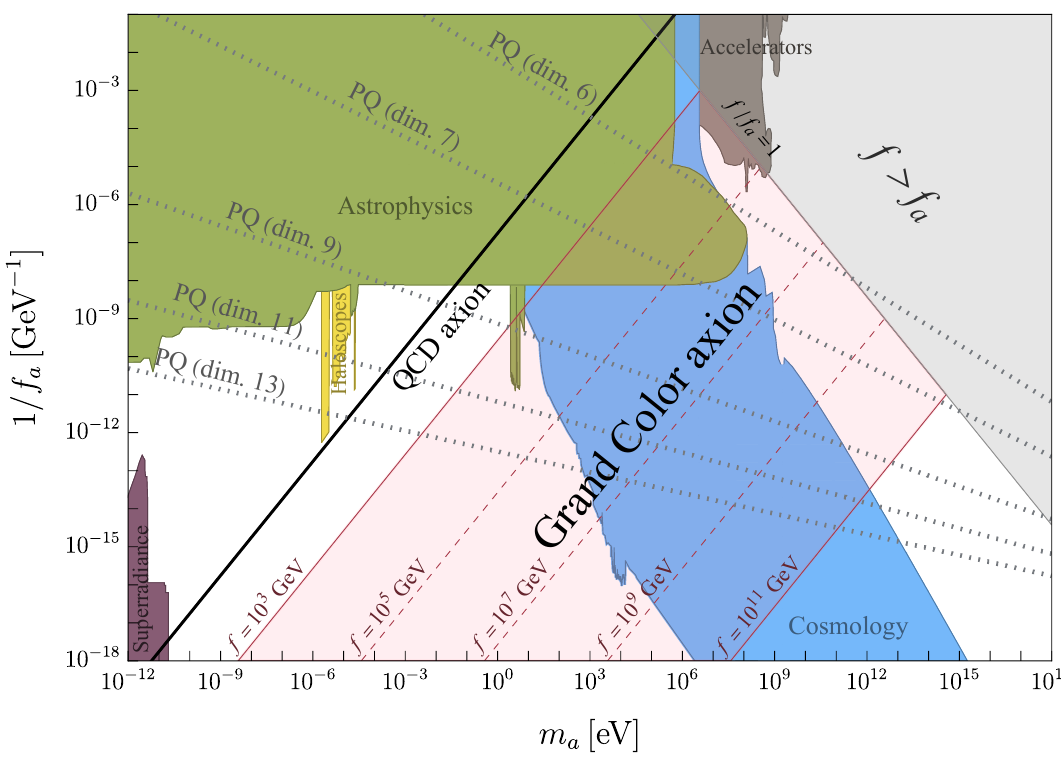
Figure 1 . Collection of the main bounds on f a vs. m a , as discussed in section 4. For definiteness we assumed N = 13 and | c ud | = 1 . The light-pink bend denoted by “Grand Color axion” identifies the region populated by our